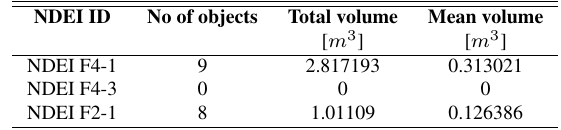
Table 8. Summary of volume changes obtained by applying the implemented algortithm to the NDEI indexes